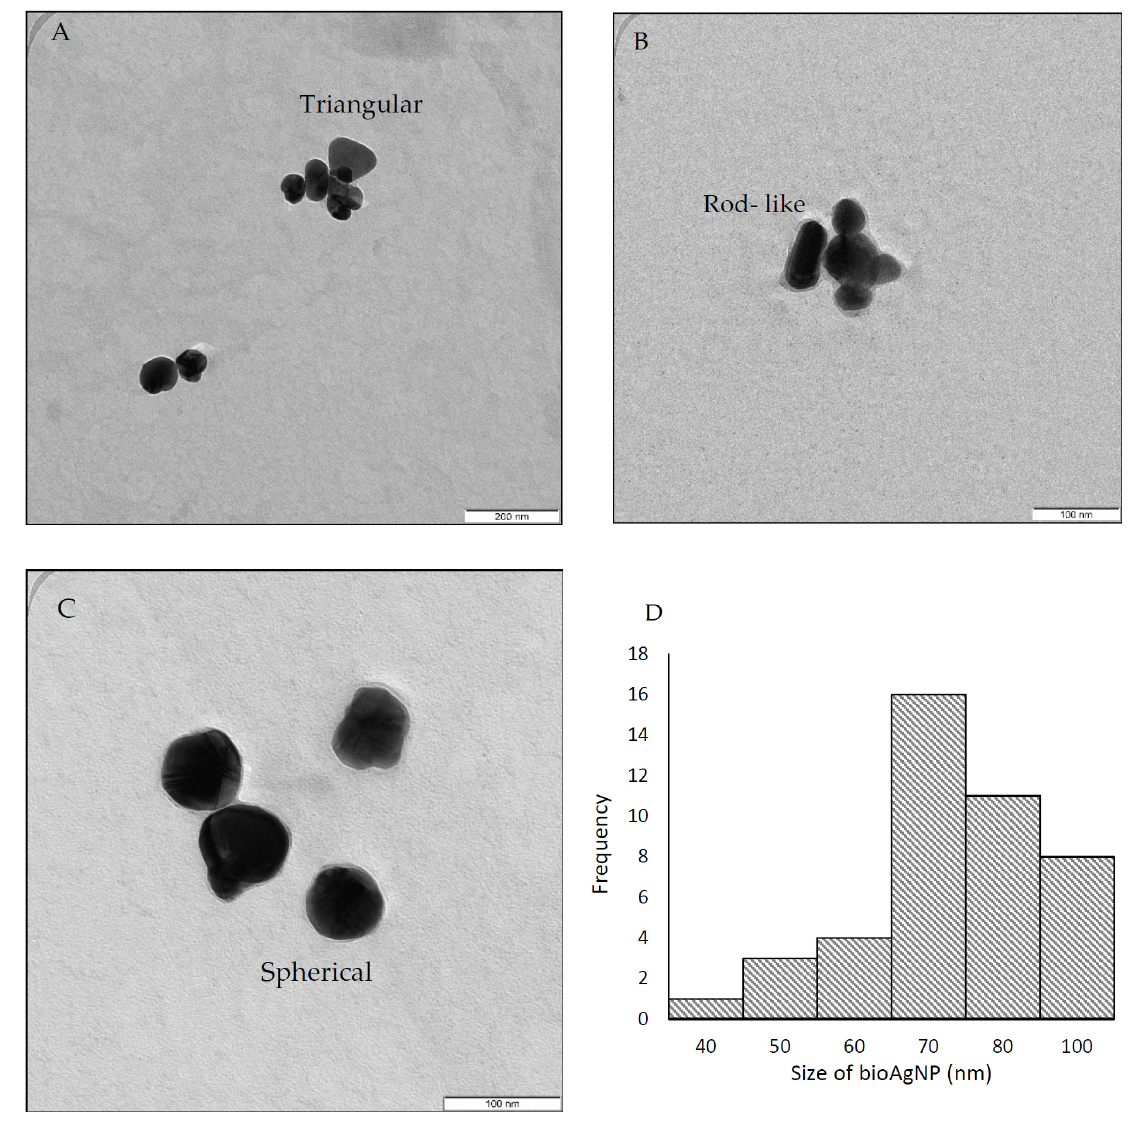
Figure 2. TEM analysis revealed the different shapes of synthesized bioAgNPs: triangular ( A ), rod-like ( B ), and spherical ( C ). The broad size distribution ranging from 40 to 100 nm ( D